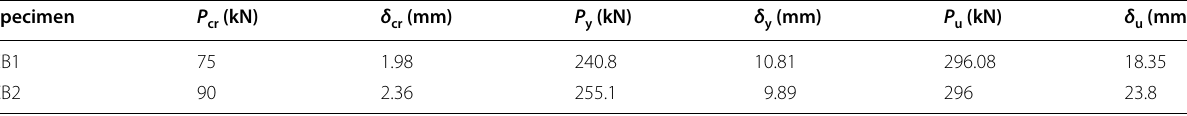
Table 3 Main test results of specimens CB1 and CB2. Specimen